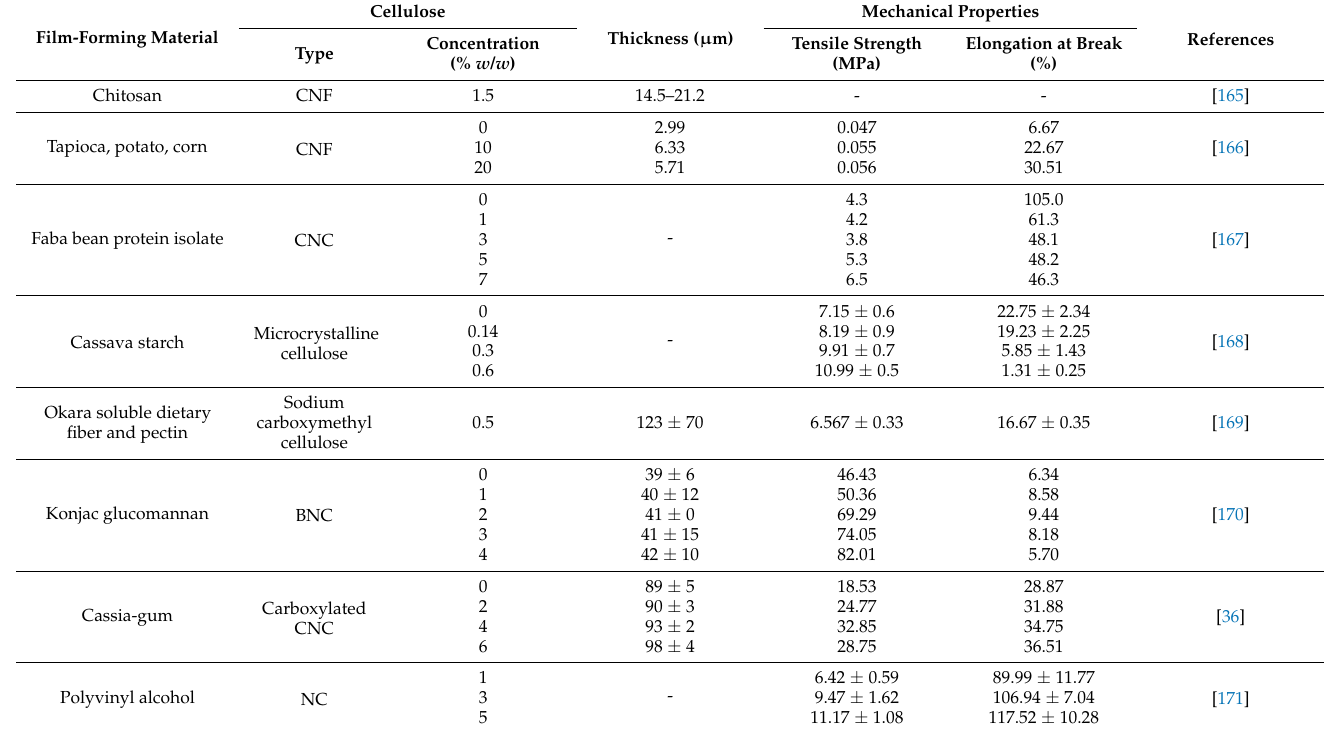
Table 7. Effect of nanocellulose (NC) on thickness and mechanical properties of edible coatings and films. Film-Forming